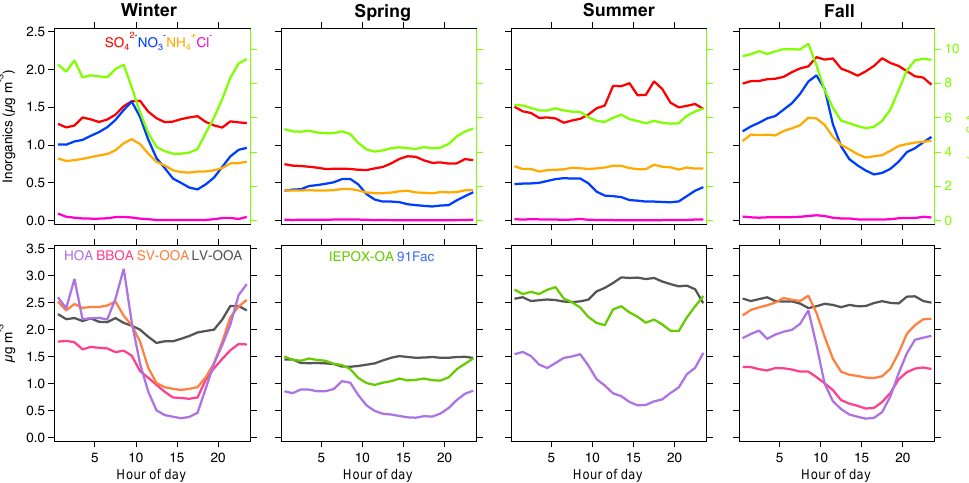
Figure 9. Diurnal variations of OA and inorganic species measured by ACSM (upper panel) and OA factors resolved by PMF analysis (lower panel) from winter, spring, summer and fall measurements at JST in 2012.